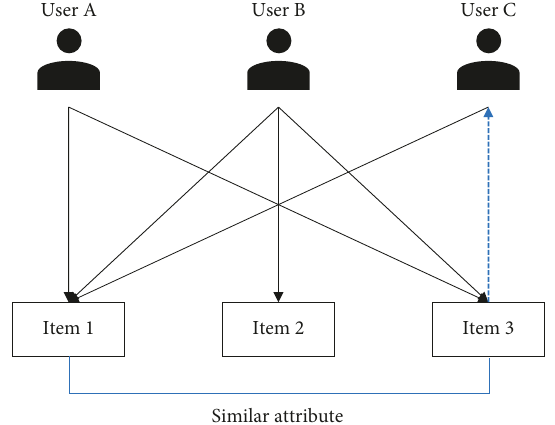
Figure 4: Principle of item-based collaborative filtering